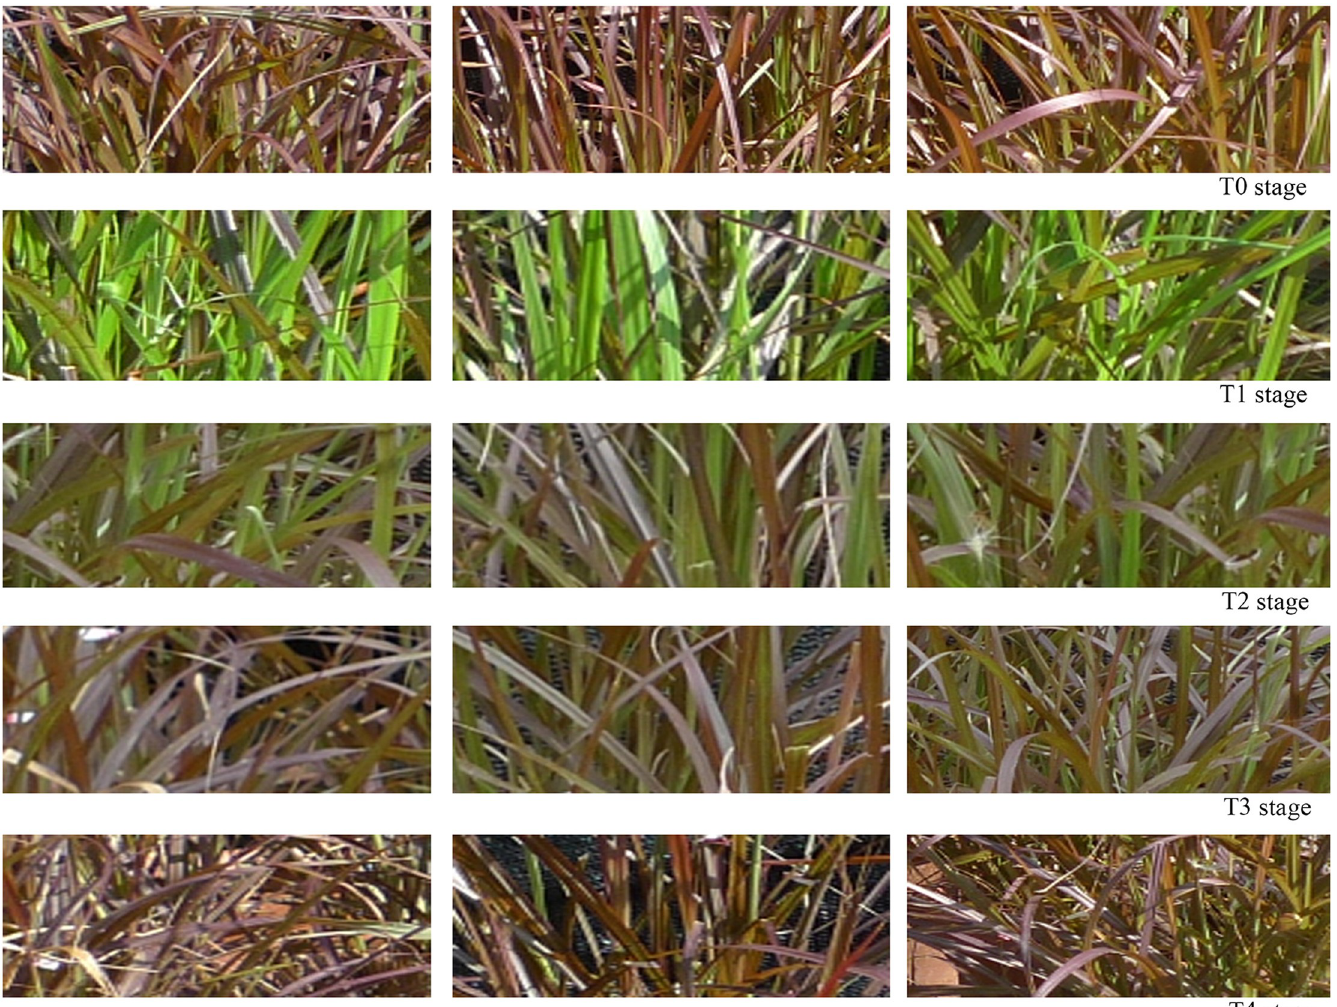
Fig 1. Dynamic changes of leaf color of Pennisetum setaceum ‘Rubrum’ in different stages. The three pictures in each row are three different plants randomly selected in each